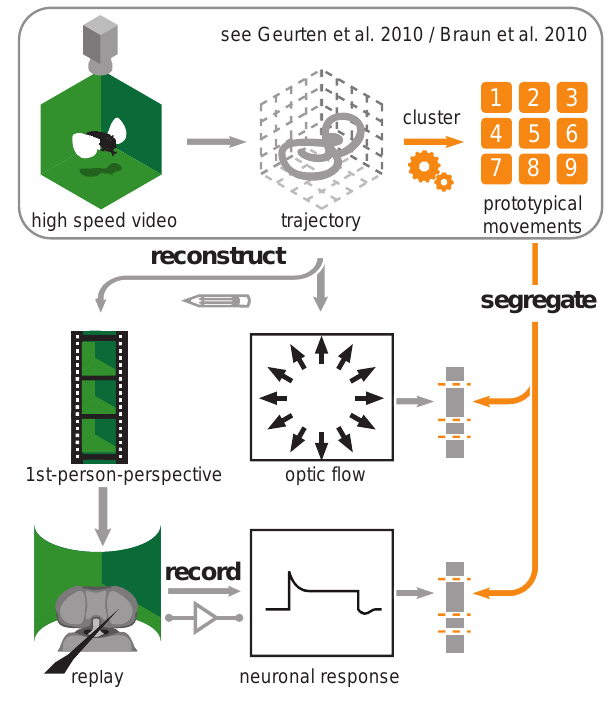
FIGURE 2 | Experimental overview. Overview of the experimental procedures used to obtain the data presented in this article.We recorded Eristalis tenax with a set of high-speed cameras (upper left corner) to obtain 3D trajectories of their flights (first row, middle). In case of Calliphora vicina Dr. van Hateren (University of Groningen, Netherlands) provided us with 3D head trajectories.We used these trajectories as data for clustering analysis that rendered nine prototypical movements (PMs; upper right corner).The first row is enclosed by a frame, which indicates that these results were already published.We used these PMs as categories and each position in the trajectories is assigned to a PM. Bearing this in mind, we reconstructed the optic flow seen while moving on a given trajectory (central picture). Now we could use the nine PMs to segregate the optic flow we calculated directly from head trajectories (second row, right). Hence we were able to calculate the optic flow from all the positions that were assigned to the same PM. Furthermore we reconstructed first person perspective movies (second row, left) from the same trajectories.We used these movies as stimuli for electrophysiological experiments (third row left). The neuronal responses from these experiments (third row, middle) could be again segregated with the PMs (third row,